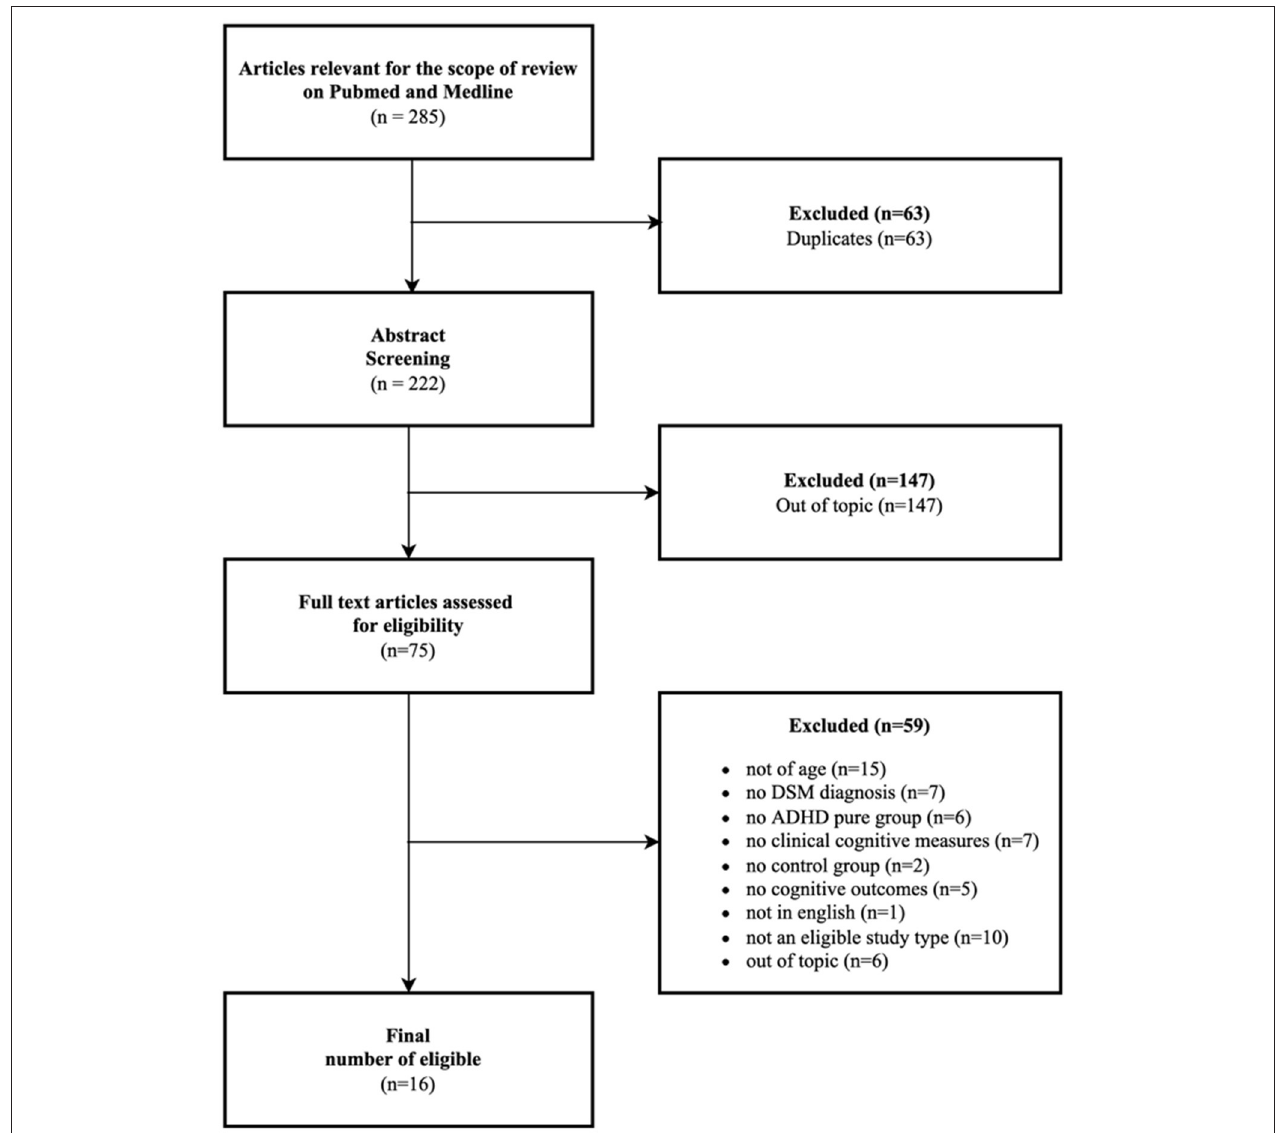
FIGURE 1 | The PRISMA flow